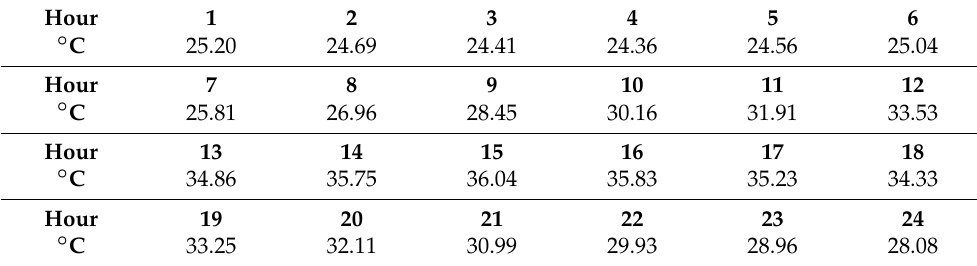
Table 12. Beijing district design